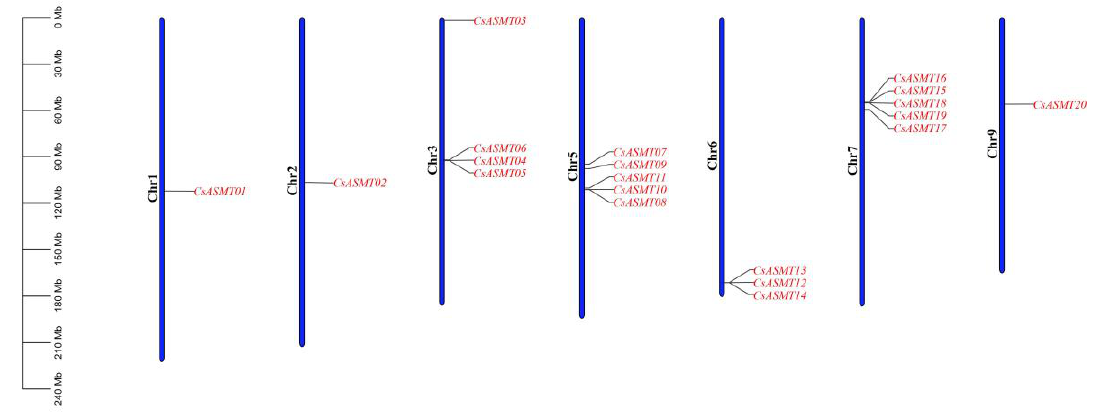
Figure 3. Chromosome localization analysis of C. sinensis ASMT gene family.